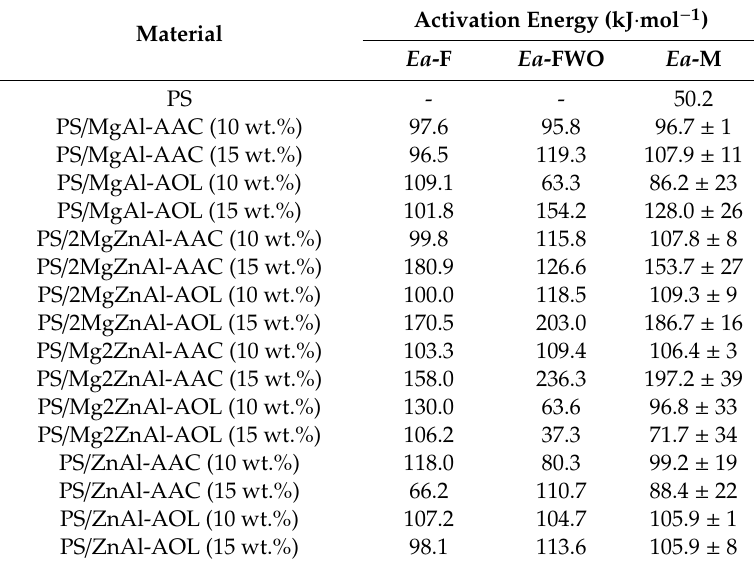
Table 8. Activation energy of the